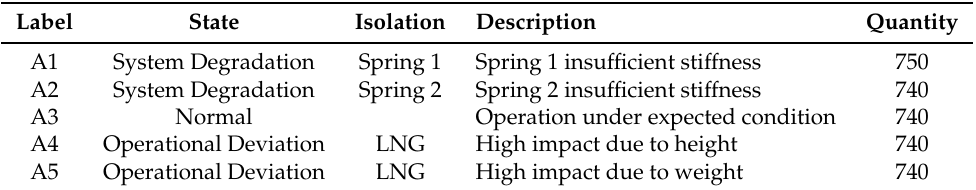
Table 5. Expected system states.